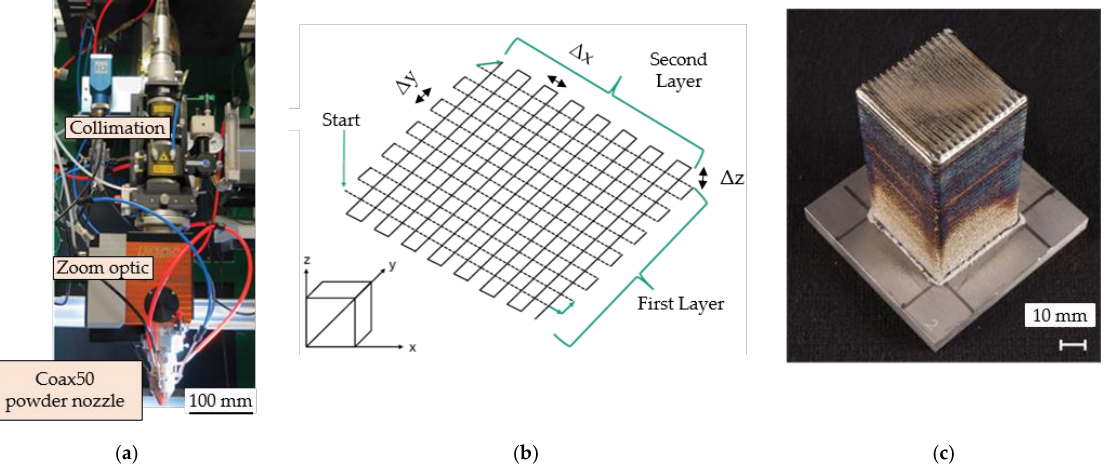
Figure 1. ( a ) L-DED set-up used in the present study, ( b ) illustration of the applied scanning strategy (schematic sketch) used for L-DED manufacturing, and ( c ) L-DED as-built sample, prior to hot deformation.